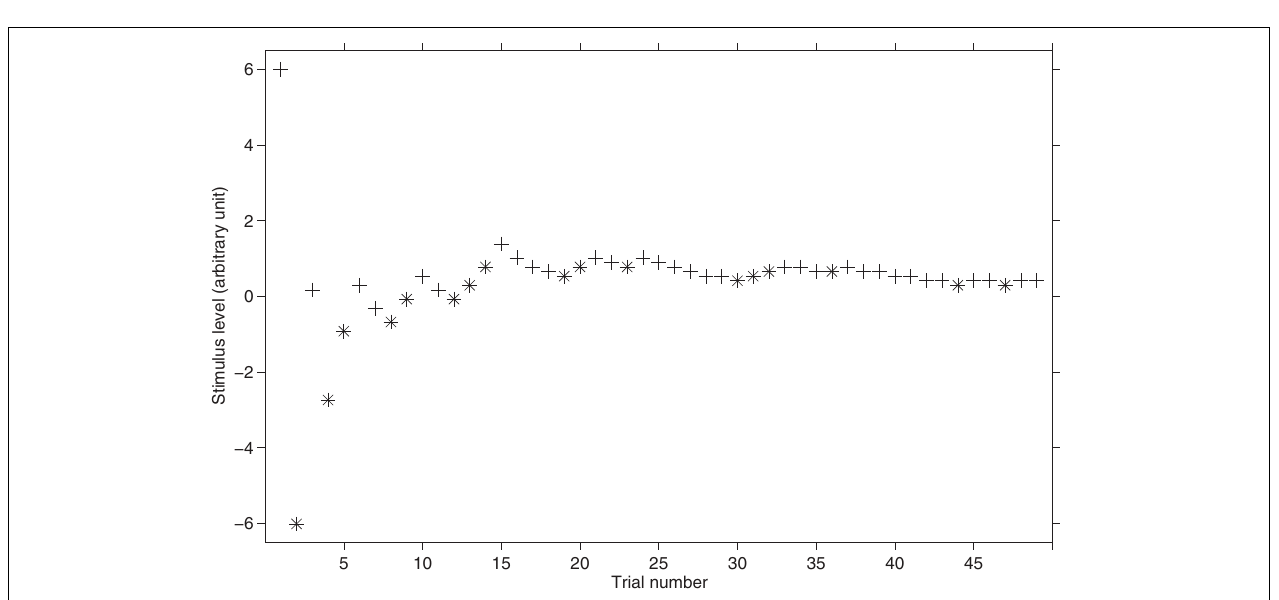
FIGURE 4 | Hypothetical threshold tracking with PEST. The plus sign represents the correct responses whereas asterisk represents the incorrect responses. The starting stimulus level is 6. W is set to 1 and step size is initially equal to 2 and it is halved twice during the block.